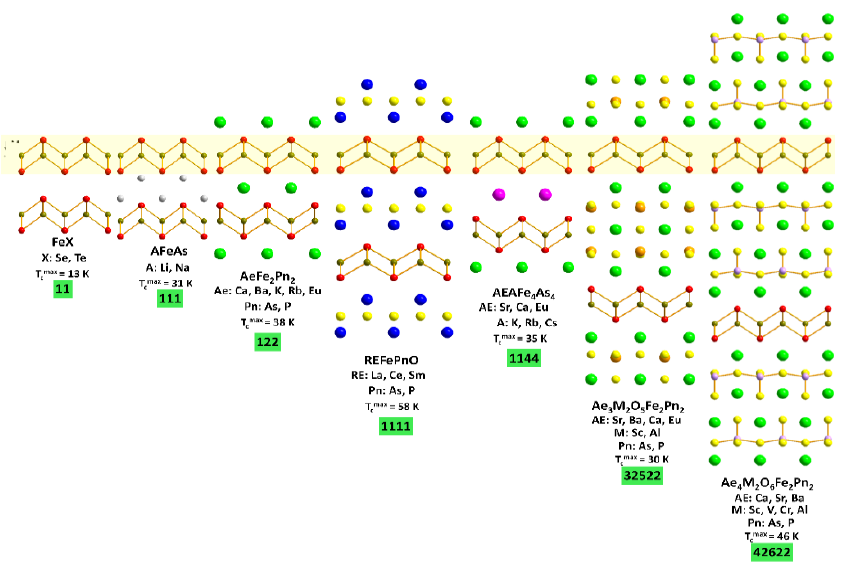
Figure 1. Various crystal structures of Iron-Based Superconductor (FBS) families with details of their abbreviations according to their stoichiometry.